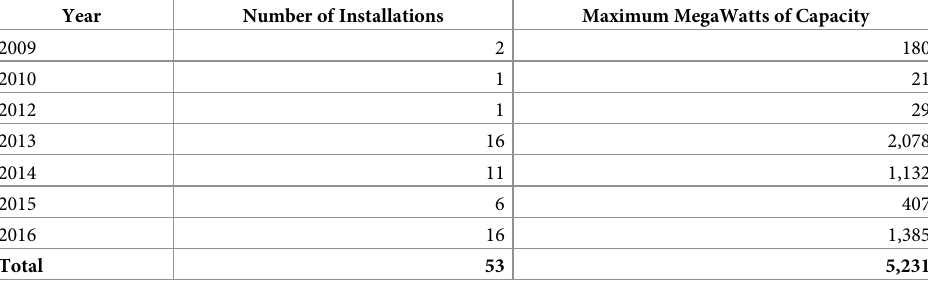
Table 1. Recent renewable energy development in the California Mojave